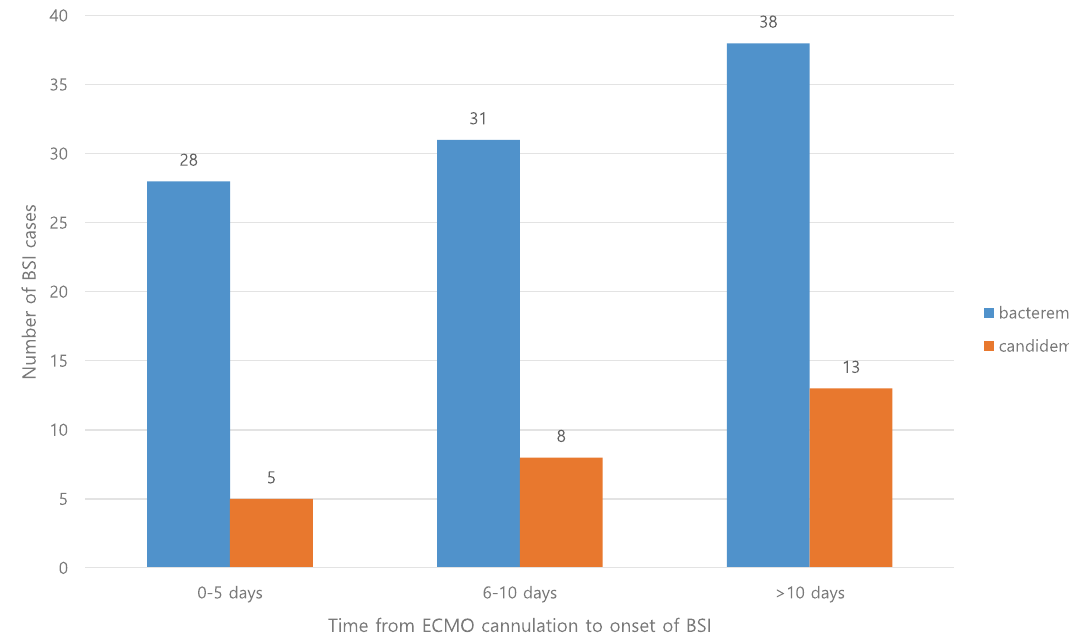
Figure 3. The number of BSI cases at different periods after ECMO cannulation. BSI bloodstream infection, ECMO extracorporeal membrane oxygenation.